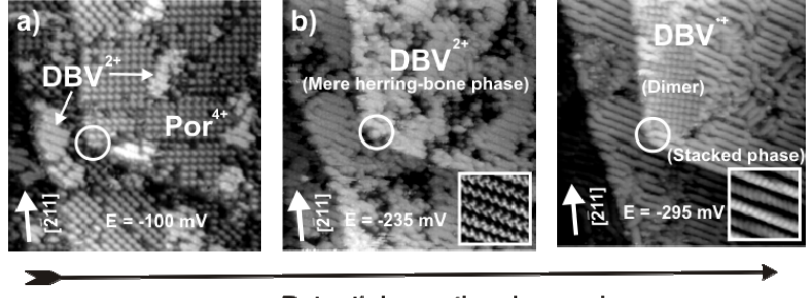
TTMAPP 4+ and DBV 2+ domains on 2 and P in Figure 11 in negative direction: 1 2